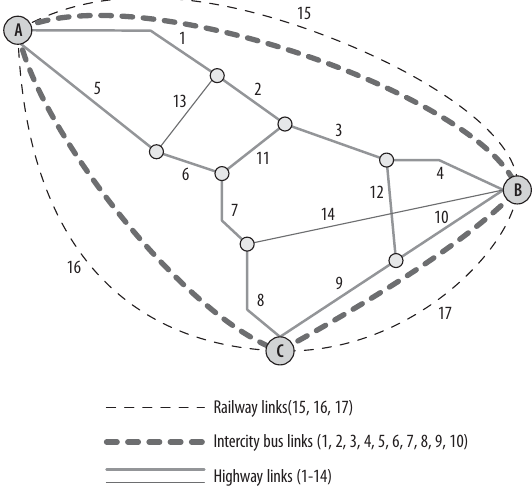
Fig. 1. Test network based on Yangtze River Delta Economic